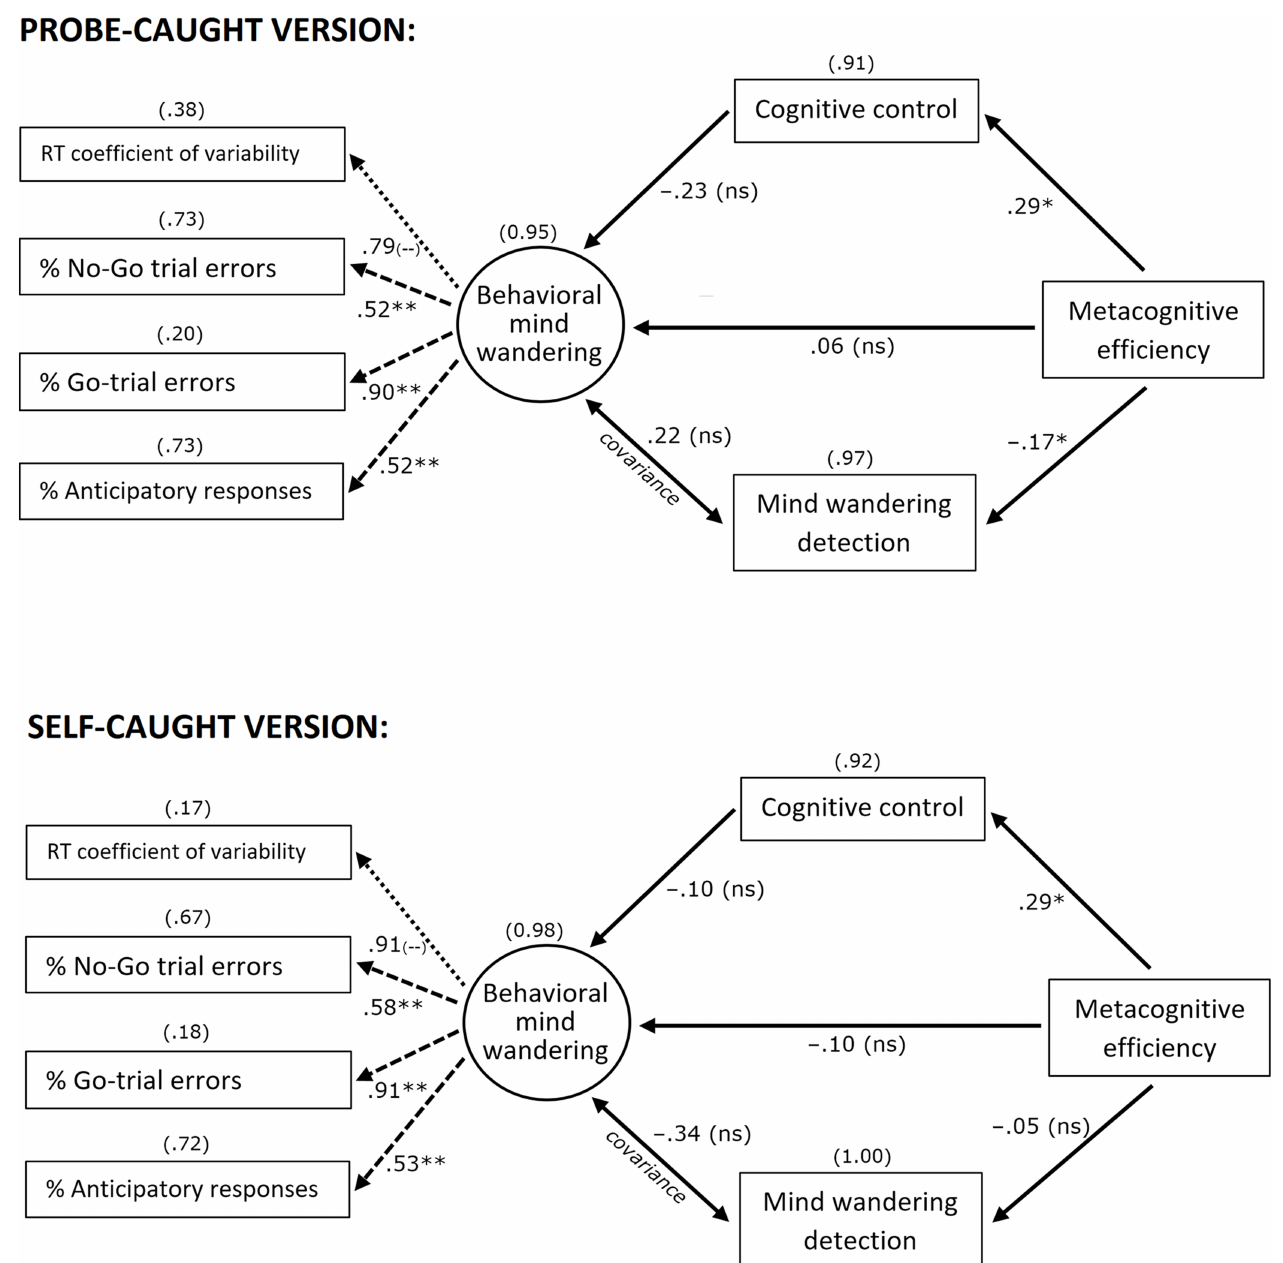
Fig 4. The structural equation model for each version of the SART. Standardized estimate values are shown for each regression, and the residual covariance. Variances are displayed in brackets above each dependent variable. (cid:3) p < .05, (cid:3)(cid:3) p < .01, (–) significance value was not